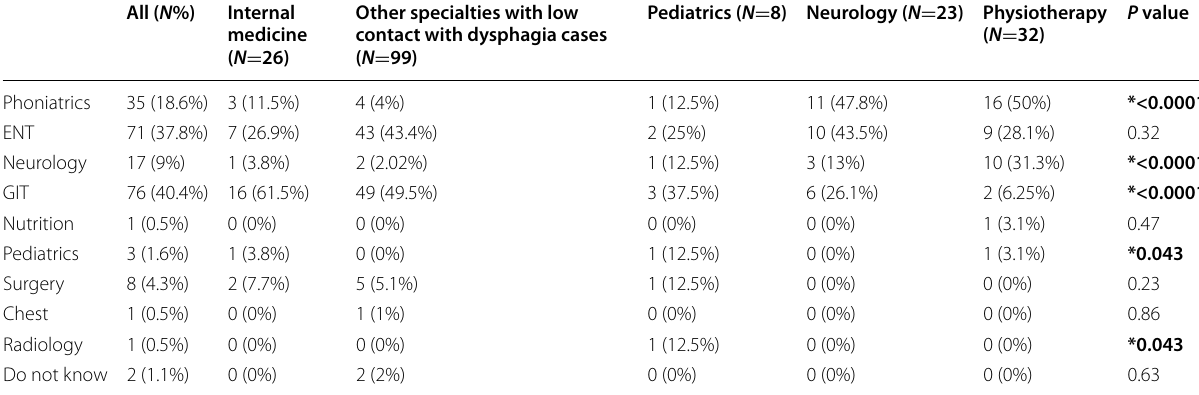
*Significant P value < 0.05